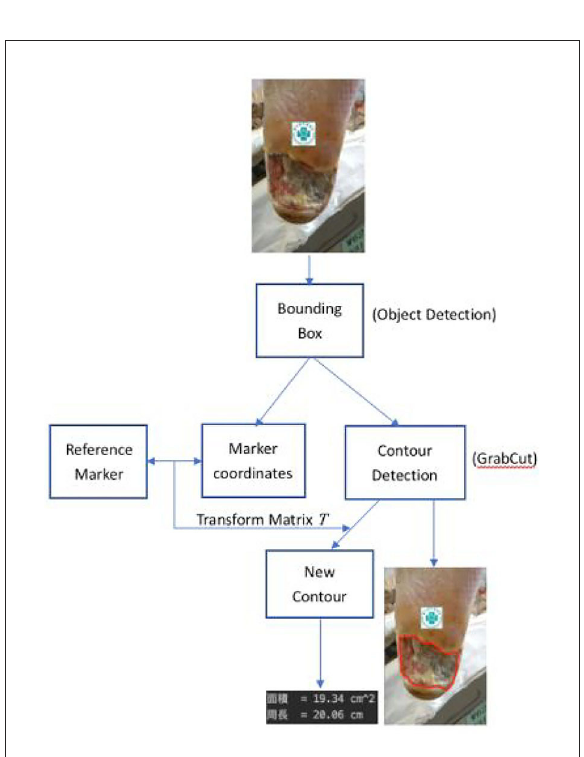
FIGURE6 Wound characteristics computation